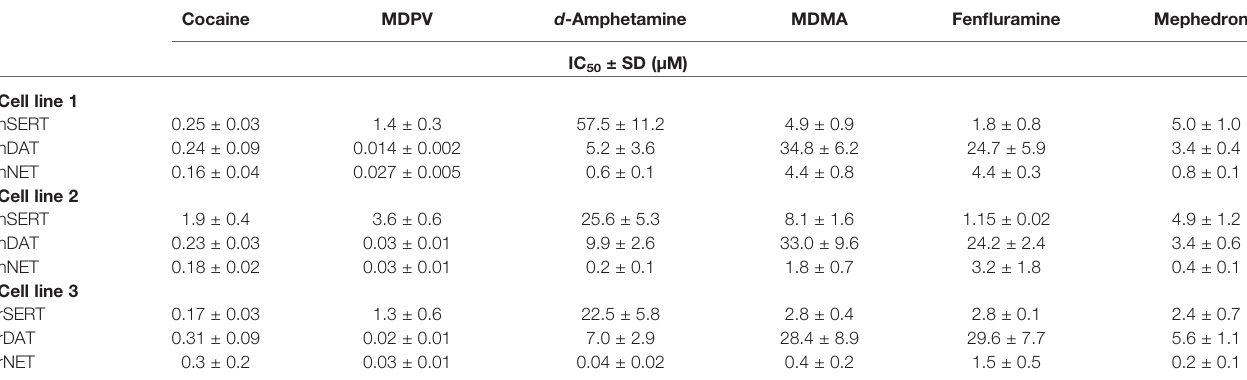
TABLE 3 | Binding inhibition of [ 3 H]-CFT to adherent HEK 293 cells expressing human and rat